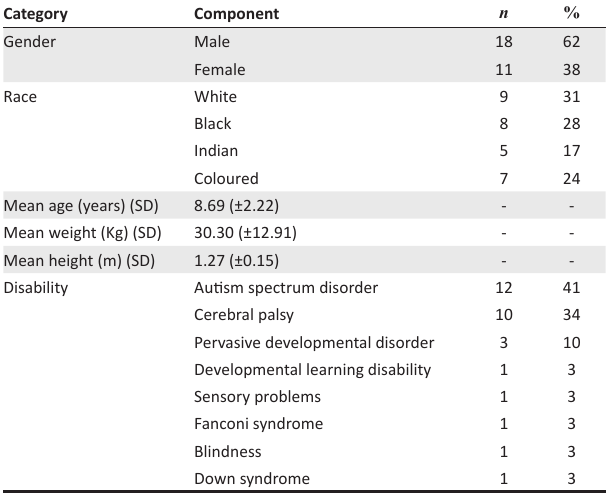
TABLE 1: Sample demographics of participants ( n = 29).